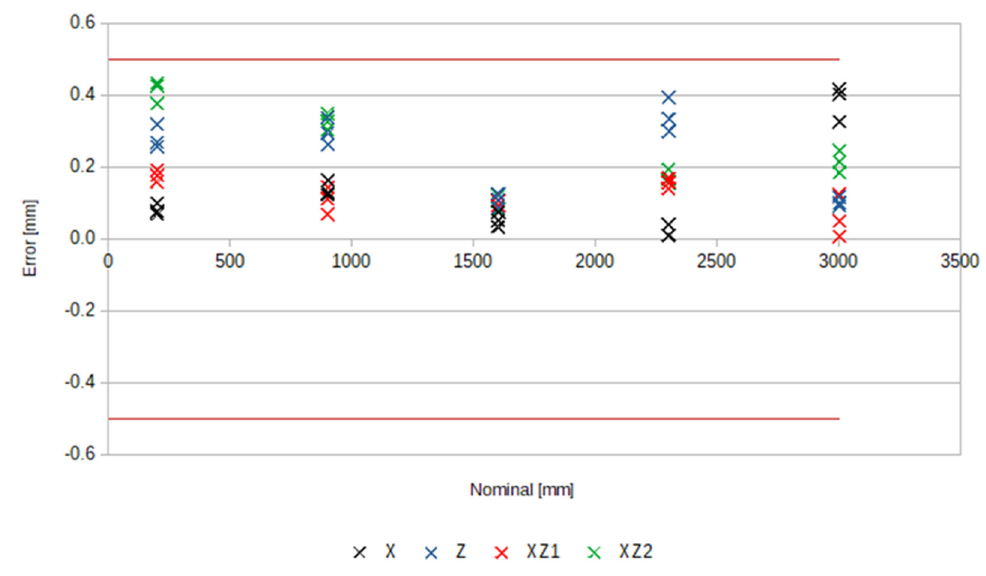
Figure 11. Error characteristic for all the tested axes